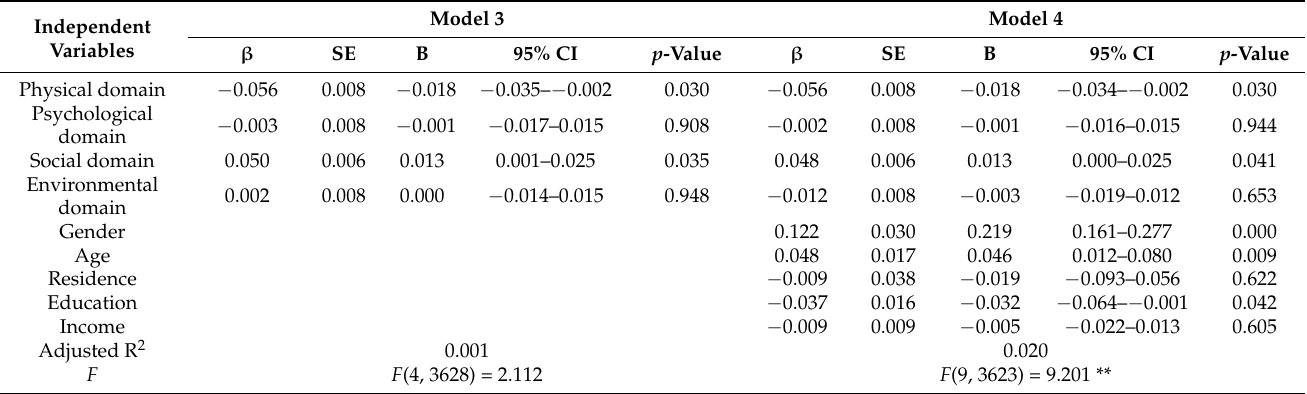
Table 4. Linear regression analysis for predicting HRBS by WHOQOL-BREF domains. Independent